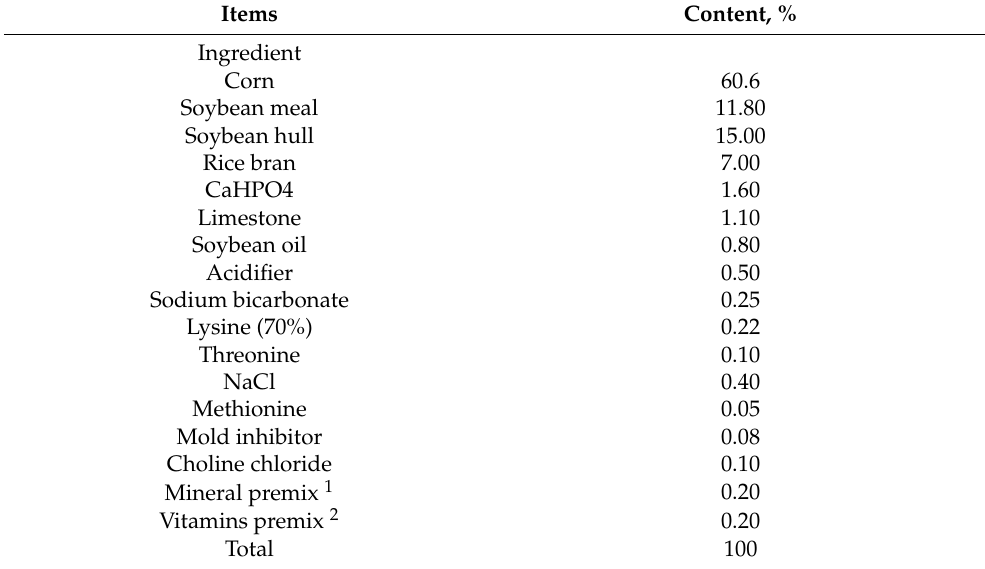
Table 1. Composition and nutrient levels of the basal diet (air-dry